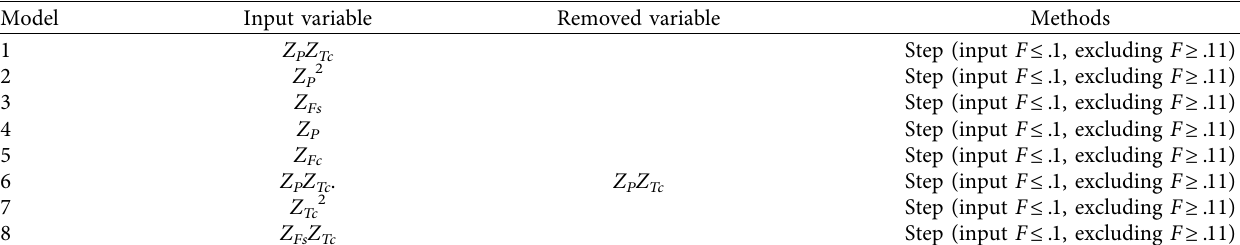
Table 3: Entered/removed variables.